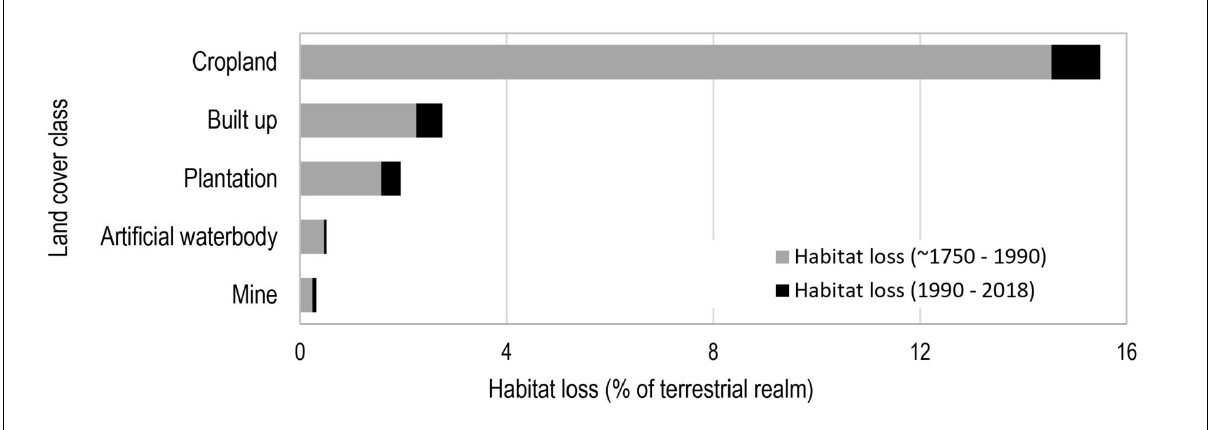
† 1750 is considered the historical baseline date, before widespread habitat loss began.